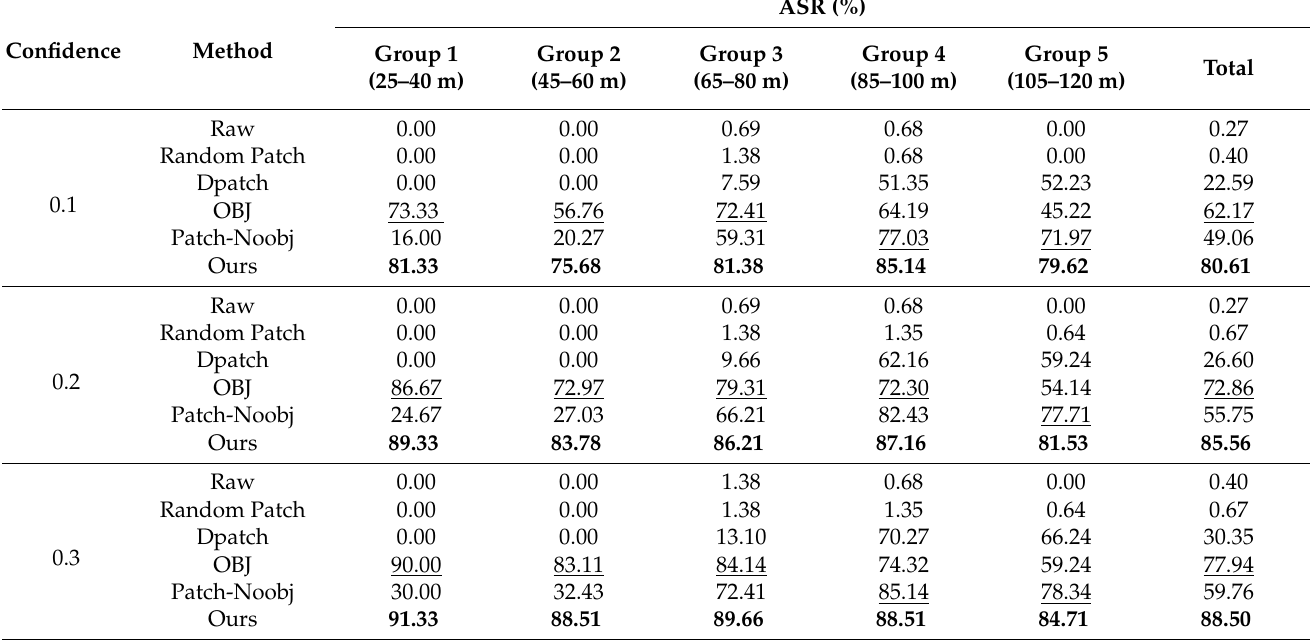
Table 1. Experimental results of different scales (25–120 m) and different confidence levels (0.1–0.6) for Yolo-V3. Specifically, the bold and underlined values indicate the sota and the second